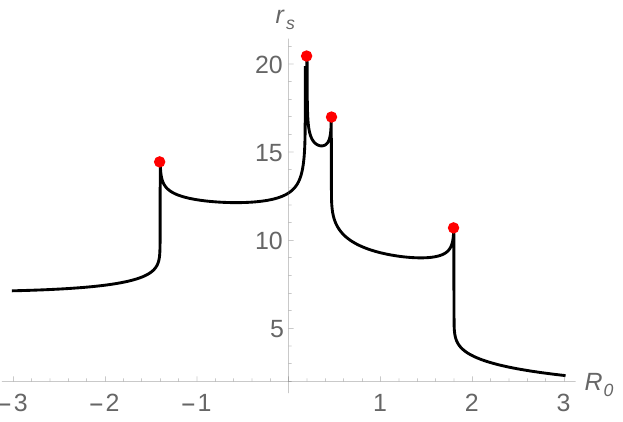
Figure 14 . Values of r s (radius where the solution becomes singular) for (cid:10) = 0 : 3. The solutions that have to be free of such singularities and extend to in(cid:12)nity appear as sharp peaks, which we marked here with red